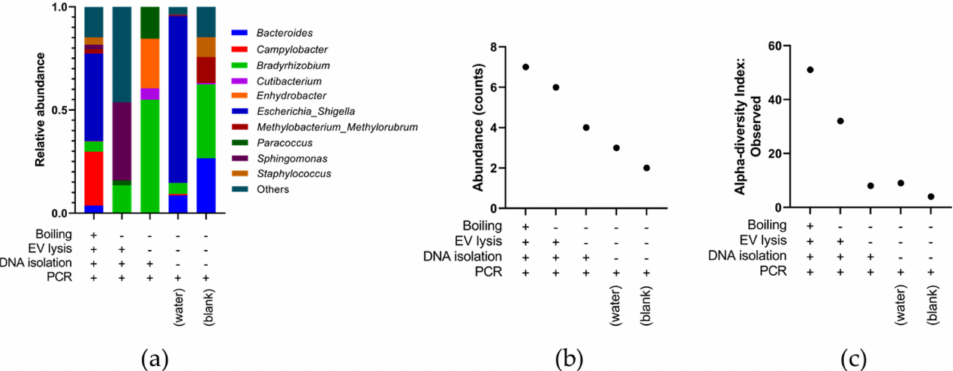
Figure A1. Taxonomic profile of the protocol control samples. ( a ) The relative abundance chart shows the top 10 most dominant taxa at the genus level. ( b ) Microbial abundance at the genera level (counts) of each protocol control sample reduces as each step of the protocol is removed. ( c ) Microbial richness measured by α -diversity also reduces as each step of the protocol is removed (ASV-level Observed Index: number of unique ASVs observed per sample).